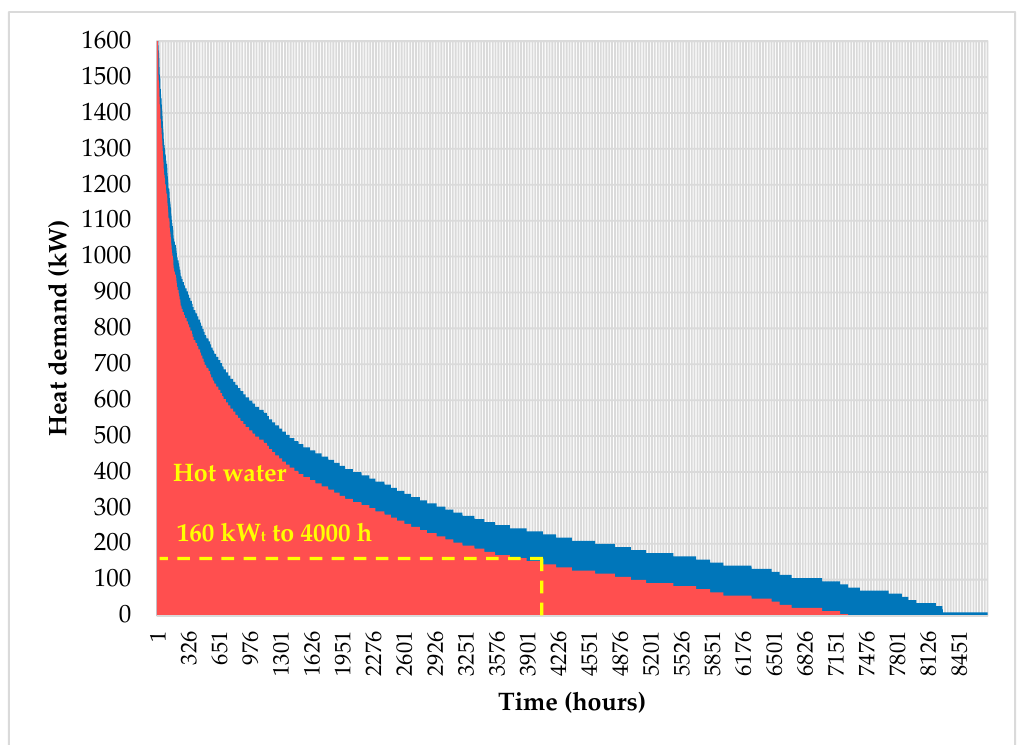
Figure 10. Load duration curve for the heat demand.